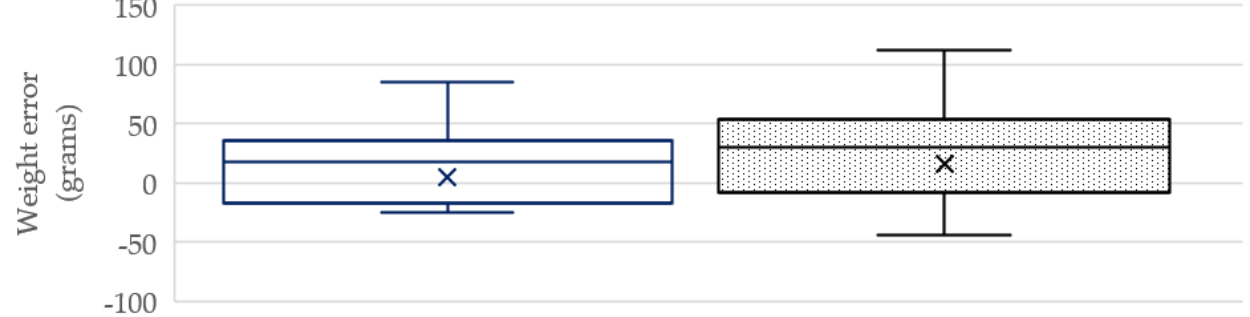
Figure 18. Comparison of the estimated weight of the proposed TWE method between the actual − value trained models and the estimated-value trained − value trained models and the estimated-value trained models.